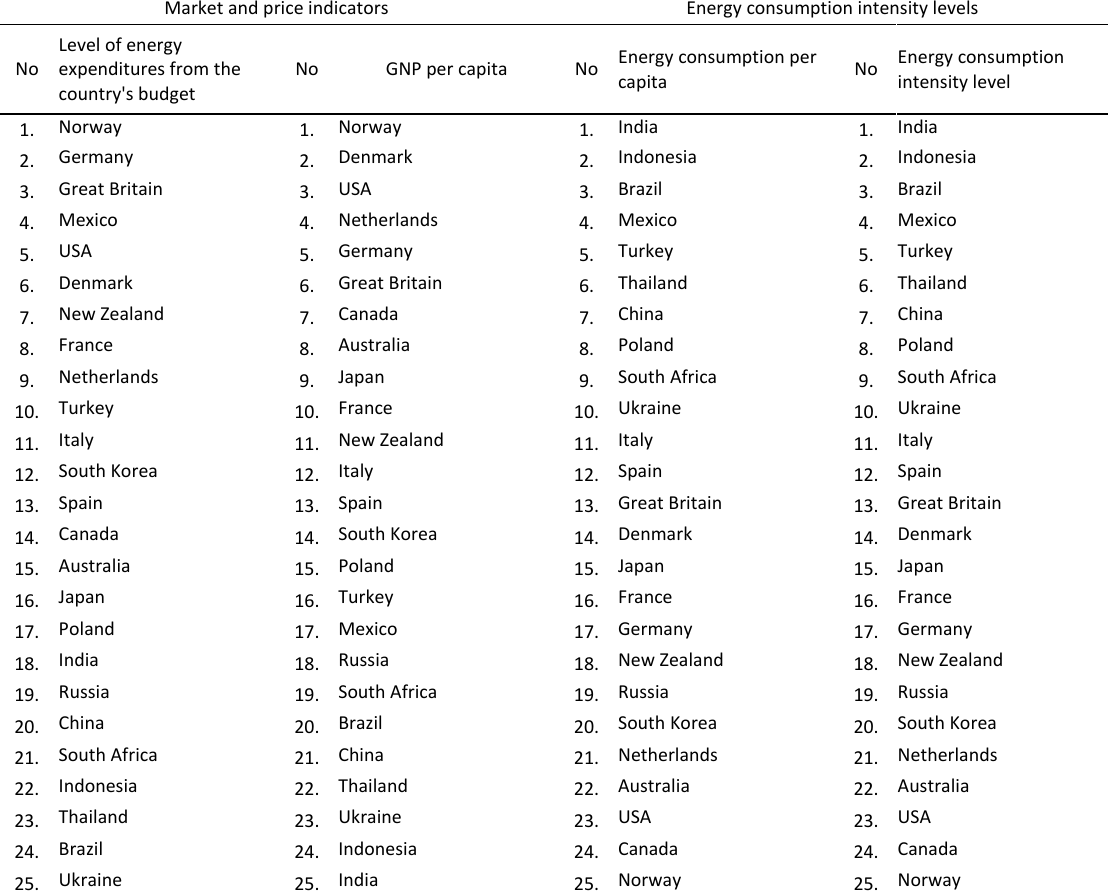
Table 3: Metric ranking of energy security levels in countries with high energy use (IIESR, 2018) Market and price indicators